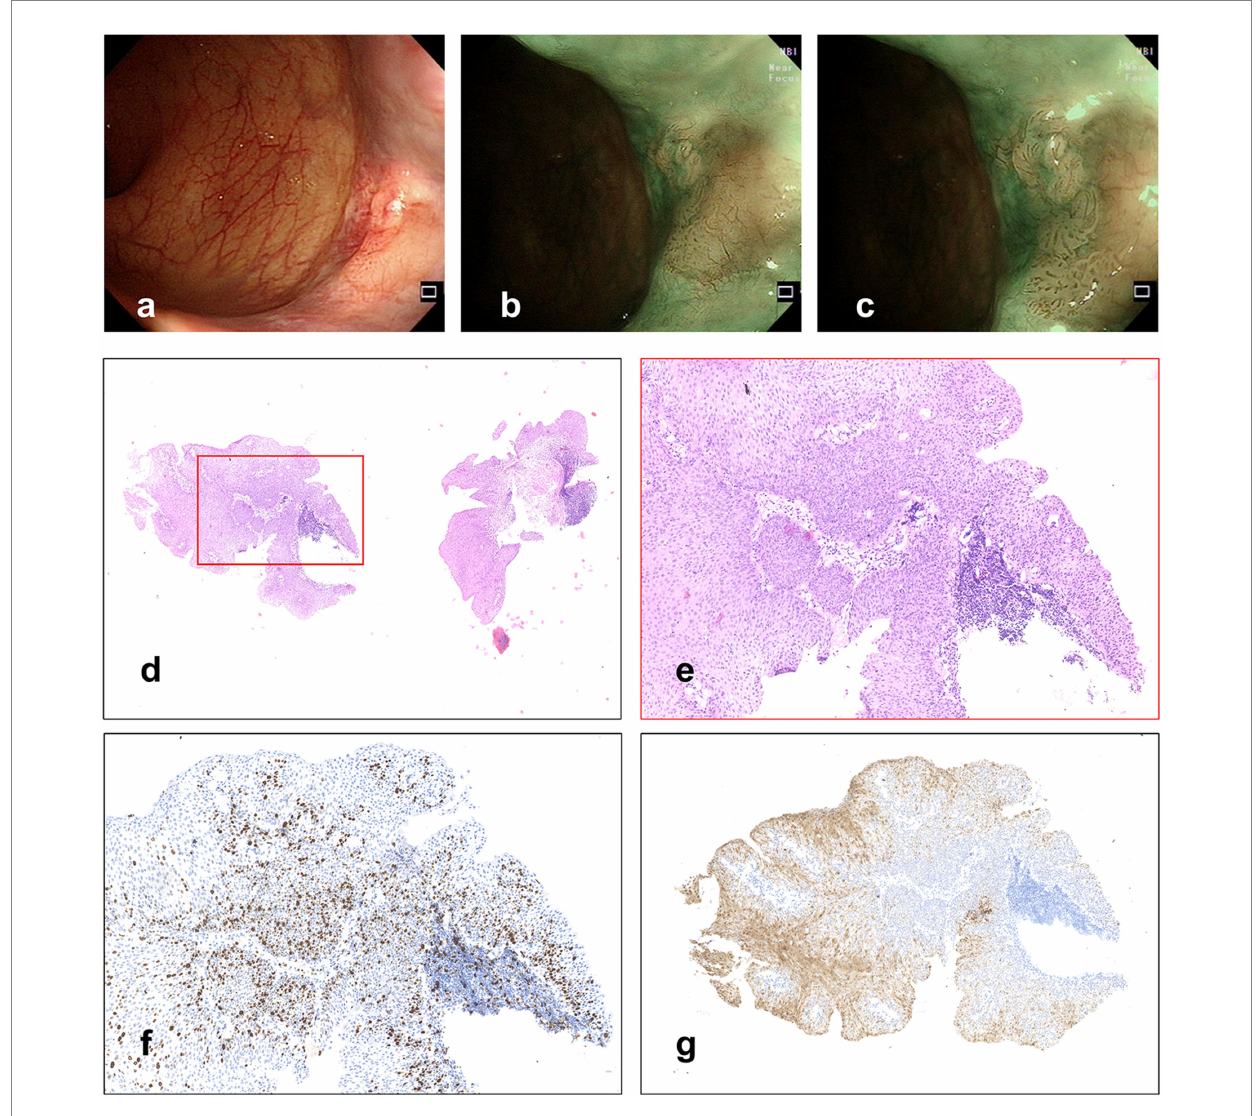
FIGURE 1 (A) A whitish superficial flat lesion with scattered reddish spots was discovered with WLI. (B,C) Lesion observed under NBI. (D,E) Hematoxylin and eosin staining of biopsy specimens, and (F) Immunochemistry stained by Ki-67, in which the Ki-67 positive proliferating cells are more than half of the epithelial layer. (G) Immunochemistry stained by